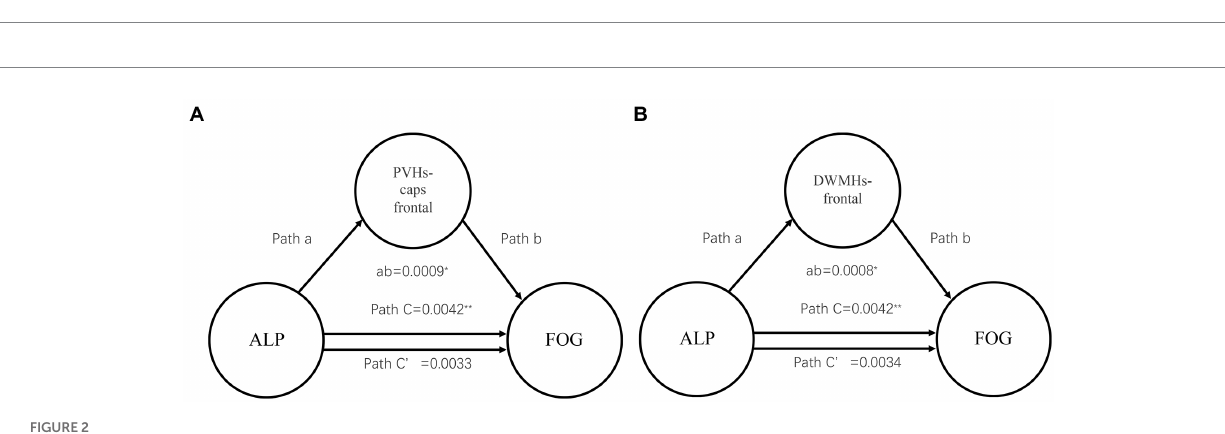
FIGURE 1 Regression analysis to determine the risk factors of each WMHs score in PD. The bar represents a 95% CI of B. The arrow indicates the value beyond the x-axis area. CI, confidence interval; * p < 0.05; (A) The risk factors of total Scheltens score; (B) The risk factors of P&D WMHs score; (C) The risk factors of PVHs-frontal caps score; (D) The risk factors of DWMHs-frontal score; B, regression coefficient.